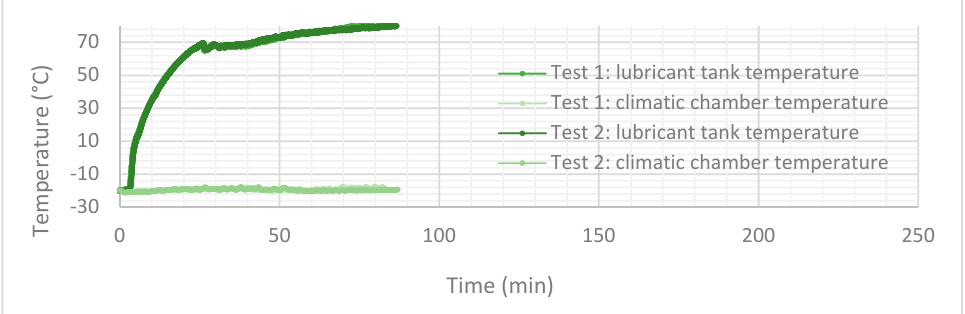
Figure A2. Lubricant tank and climatic chamber temperature trend at a thermostatic temperature of − 10 °C during the three repetitions.